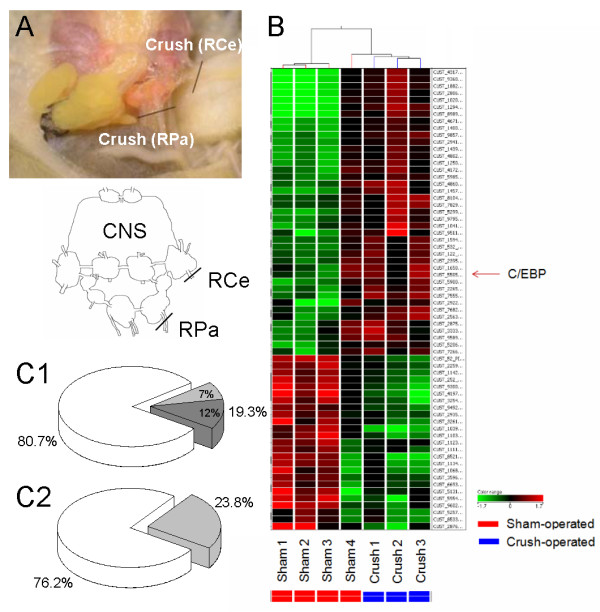
Experimental model and changes in gene expression following injury. (A) The dorsal surface of L. stagnalis CNS and CNS injury protocol: both right parietal (RPa) nerves and right cerebral nerves (RCe) were crushed with fine forceps. Inset: a schematic diagram of the ganglia and location of injury (black lines). (B) Heat map representing the hierarchical clustering of 67 genes showing significant differential expression (P < 0.05). The expression pattern of each gene in the sham and crashed groups is displayed as a horizontal strip. For each gene, the expression ratio of the crush-operated to the sham-operated experiments is represented by the green and red scale at the bottom of the figure. The genes are numbered on the right, and the experimental groups are labelled on the bottom. (C) Ratio of the regulated EST sequences 3 hrs following CNS injury in L. stagnalis. (C1) The signal intensity of 348 genes or ESTs was differentially regulated. Open pie (80.7%) represents genes/EST's changes < 2.0-fold in signal intensity but significant (P < 0.05); grey pie (19.3%): changes ≥ 2.0-fold (P < 0.05). Dark grey: up-regulated genes (12%), and light grey: down regulated genes (7%). (C2) Ratio of the 67 differentially regulated genes, 16 (23.8%) genes have orthologous with known functions related to development, survival or signal transduction, whereas 51 (76.2%) genes have no orthologue.